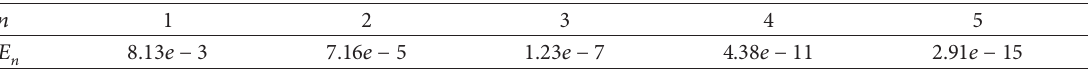
Table 4: The absolute maximum errors 𝐸 𝑛 for example 3 .